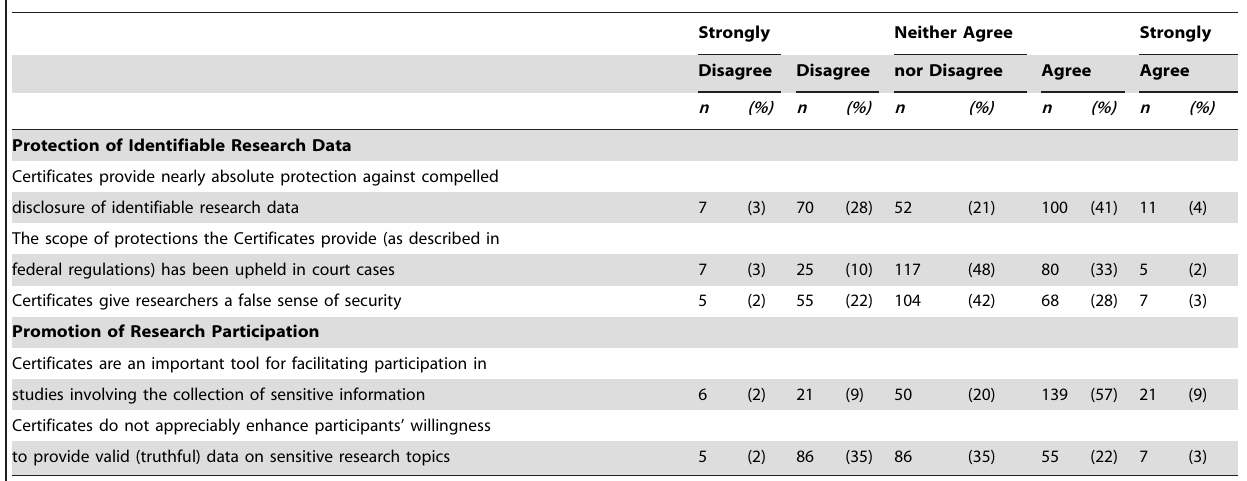
Table 4. Opinions about Certificates of Confidentiality (n=246).